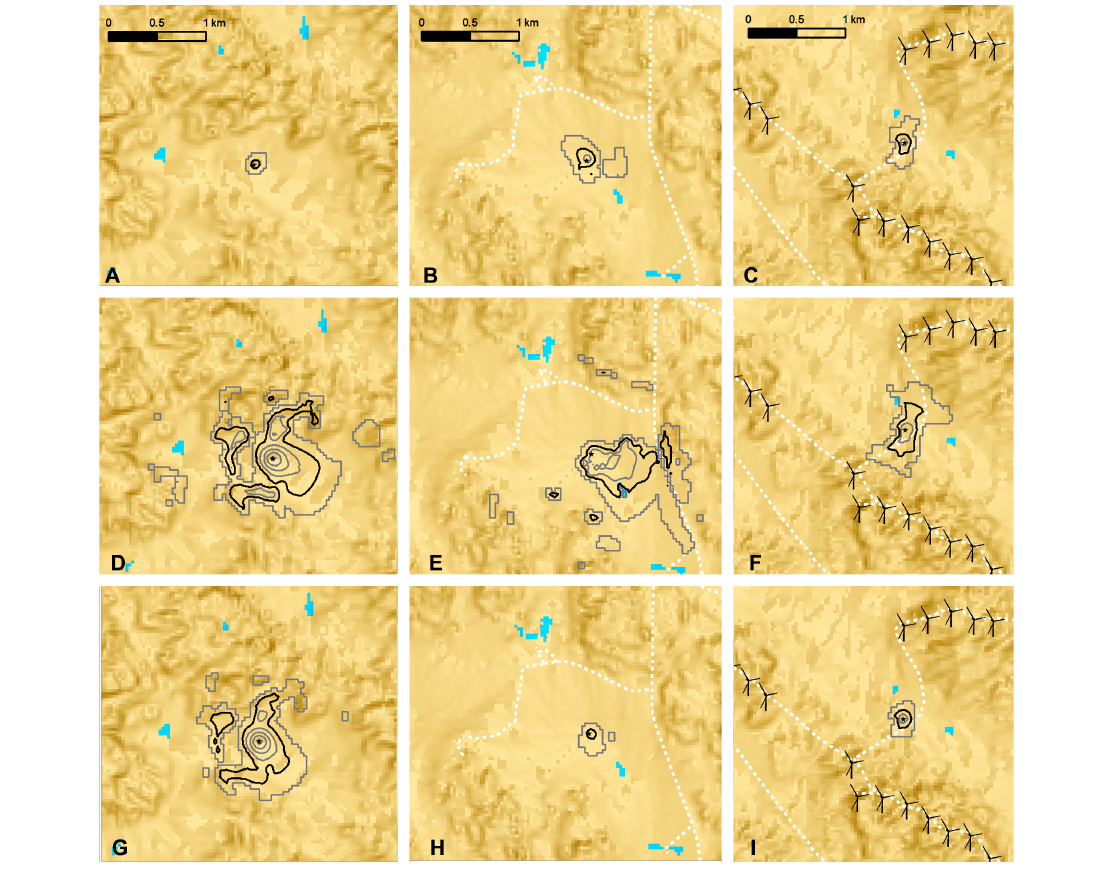
Fig. 3 . Propagation of male Greater Prairie-Chicken ( Tympanuchus cupido ) boom chorus predicted at a one-third octave frequency bandwidth of 0.315 kHz over the lekking season (early April [top row], late April [middle row], and late May [bottom row]) from three representative leks: left panel (A,D,G) is a lek > 1365 m from a road/wind facility, middle panel (B,E,H) is a lek within 620 m of a road, and right panel (C,F,I) is lek within 920 m of the wind energy facility. Boom chorus propagation is shown with 5 dB contours (gray lines) around each lek (black dot in center of contour lines) near Ainsworth, Brown County, Nebraska, USA. Black lines indicate area where the predicted boom chorus sound level (dB) has fallen to 5 dB above ambient background level, and the outermost gray contour line indicates where boom chorus meets background level, 0 dB. White dashed lines are